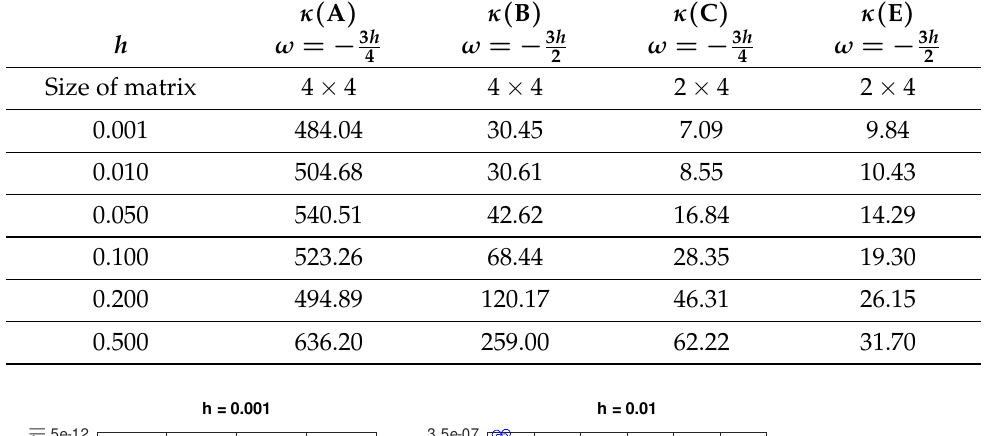
Table 3. Comparison of the condition numbers for the matrices derived from Example 3.